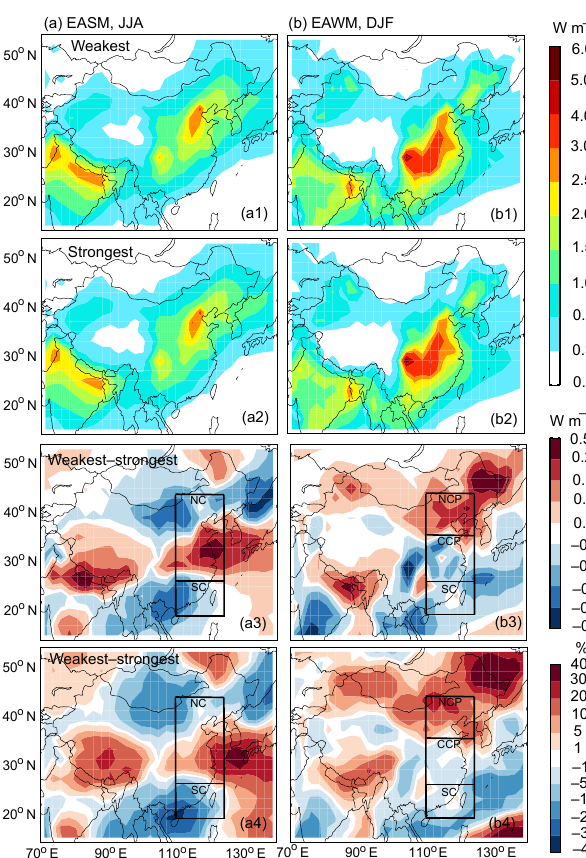
Figure 8. (a) Simulated JJA mean all-sky direct radiative forcing (DRF) of BC (Wm − 2 ) at the top of the atmosphere (TOA) in the (a1) 5 weakest and (a2) 5 strongest EASM years during 1986–2006 from model simulation VMET. Also shown are the (a3) absolute (Wm − 2 ) and (a4) percentage (%) differences between the 5 weak- est and 5 strongest EASM years. (b) Same as (a) , but for simulated DJF mean all-sky TOA DRF of BC in the 5 weakest and 5 strongest EAWM years. The enclosed areas are defined as northern China (NC; 110–125 ◦ E, 28–45 ◦ N), the North China Plain (NCP; 110– 125 ◦ E, 36–45 ◦ N), the Central China Plain (CCP; 110–125 ◦ E, 28–